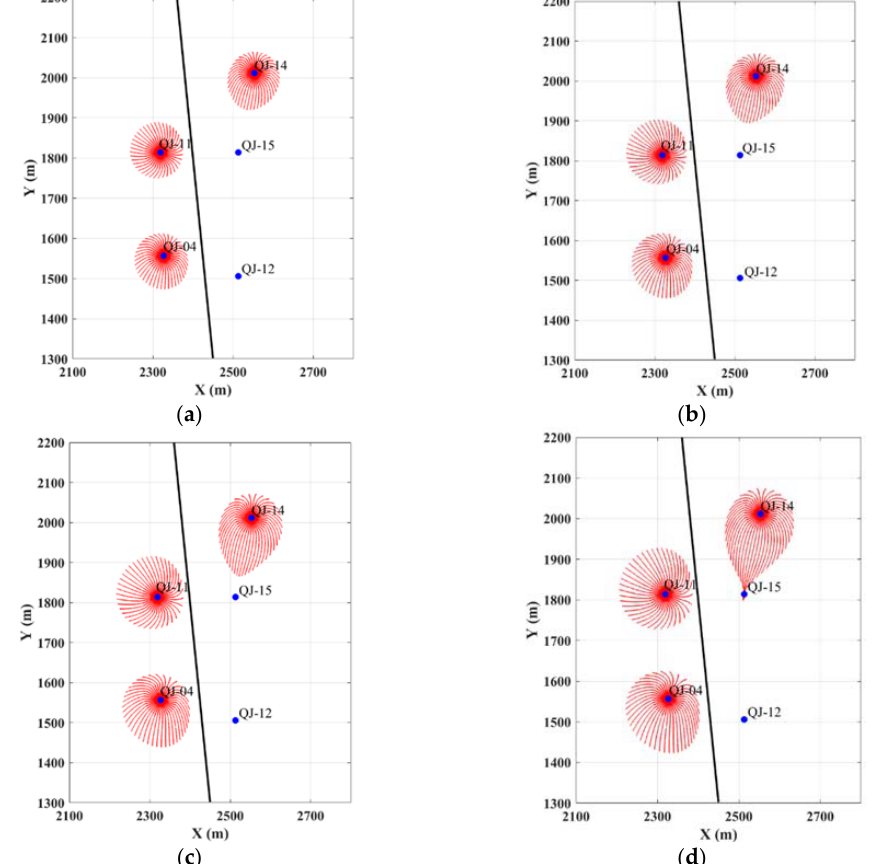
Figure 7. Streamline simulation results with an impermeable fault. ( a ) 0.8 day; ( b ) 1.2 day; ( c ) 1.6 day; ( d ) 2 day.